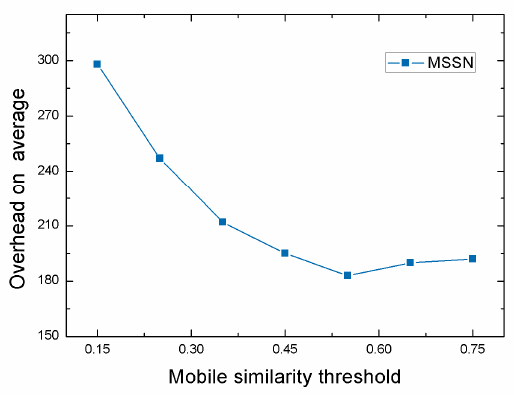
Figure 7. Overhead on average with various mobile similarity threshold.